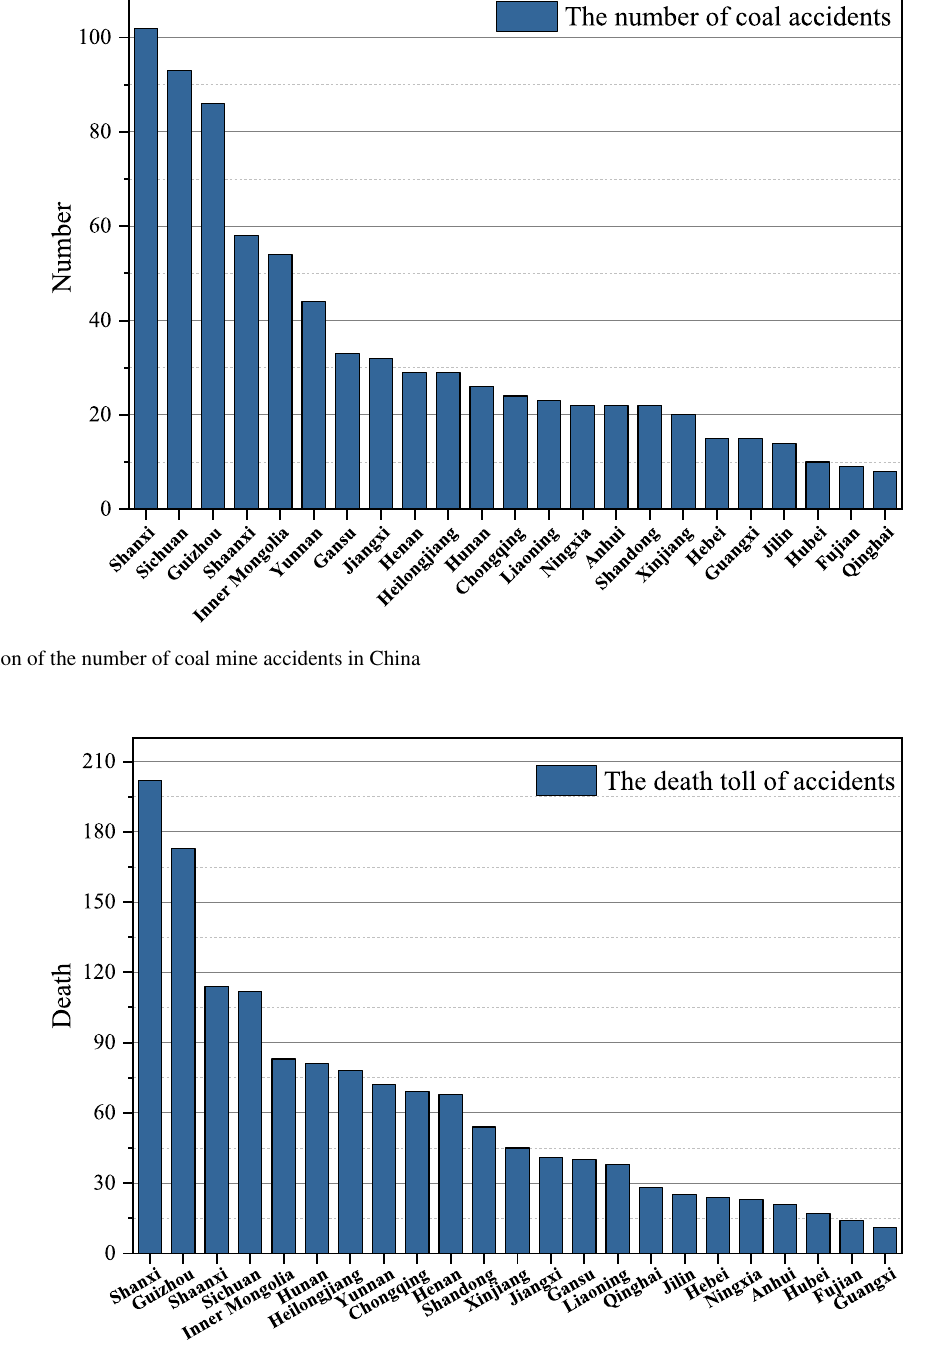
Fig. 9 Distribution of the death tolls in coal mine accidents in